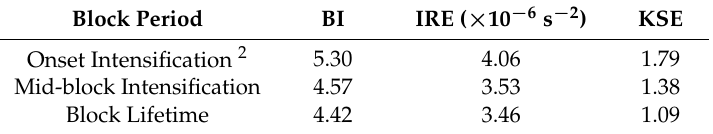
Table 2. As for Table 1, except for the winter 2017 blocking event studied here.